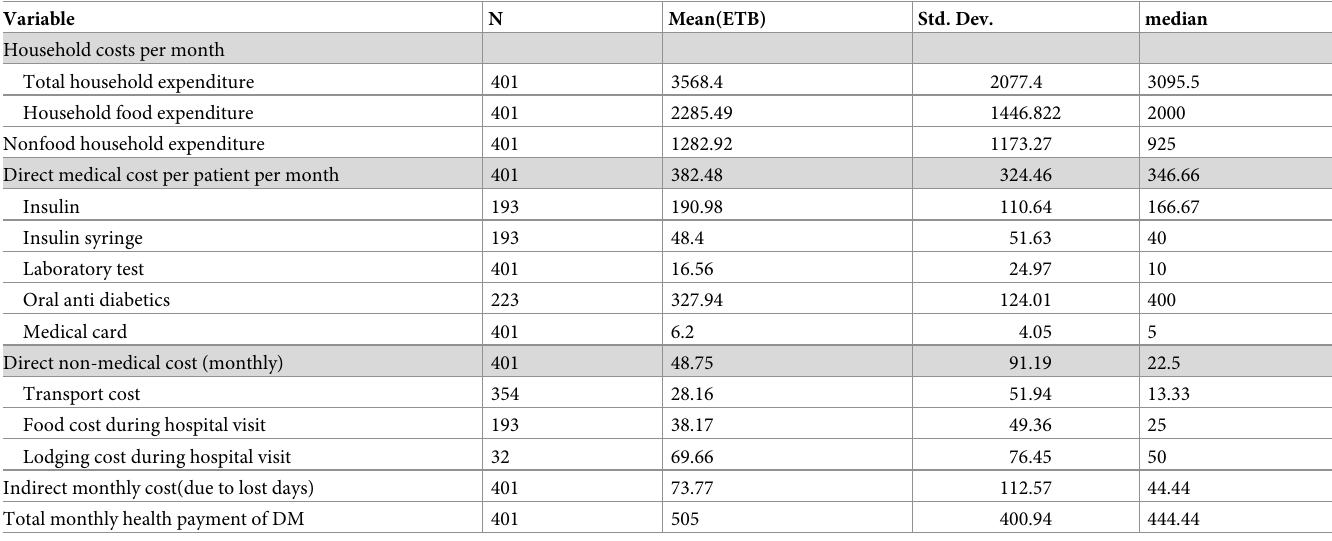
Table 2. Expenditures of diabetic patients in Bahir Dar city administration public hospitals, Ethiopia, 2019.